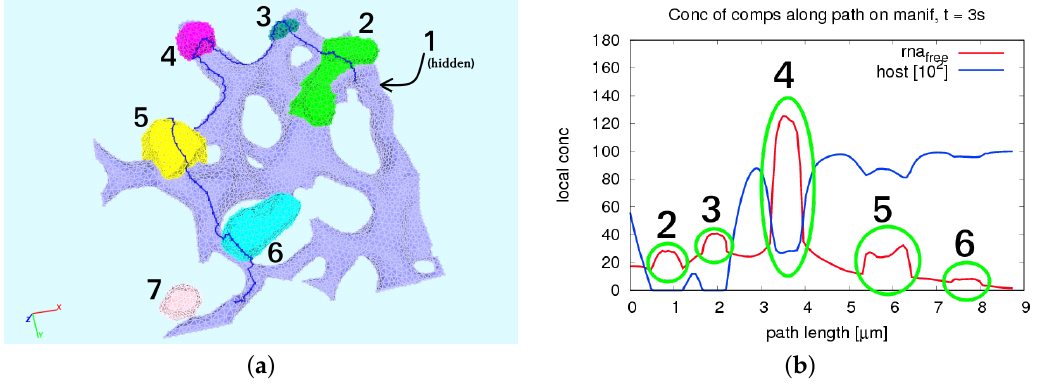
Figure 9. Web regions and their reflection within the evaluation of the concentrations of free HCV RNA and host factor along the 1D trajectories as introduced in Figure 2. Web region #1 is not visible from the given perspective. Therefore, we also did not include it within the path of evaluation. In the left picture ( a ), we show the numbering of the web regions, whereas in the right picture ( b ), we see the reflection of the web regions along the trajectories by means of the changes of the concentration values. We choose the time point t = 3 s to demonstrate the relation of free HCV RNA peaks within the webs (and host factor depletion), since, at this time point, all free HCV RNA peaks corresponding to its respective web region are at least somewhat visible. We mark the free HCV RNA peaks with a green circle. The host factor depletion centers are visible at the same locations of the path length (i.e., x ) axis. Compare also Figure 7 for time evolution along this